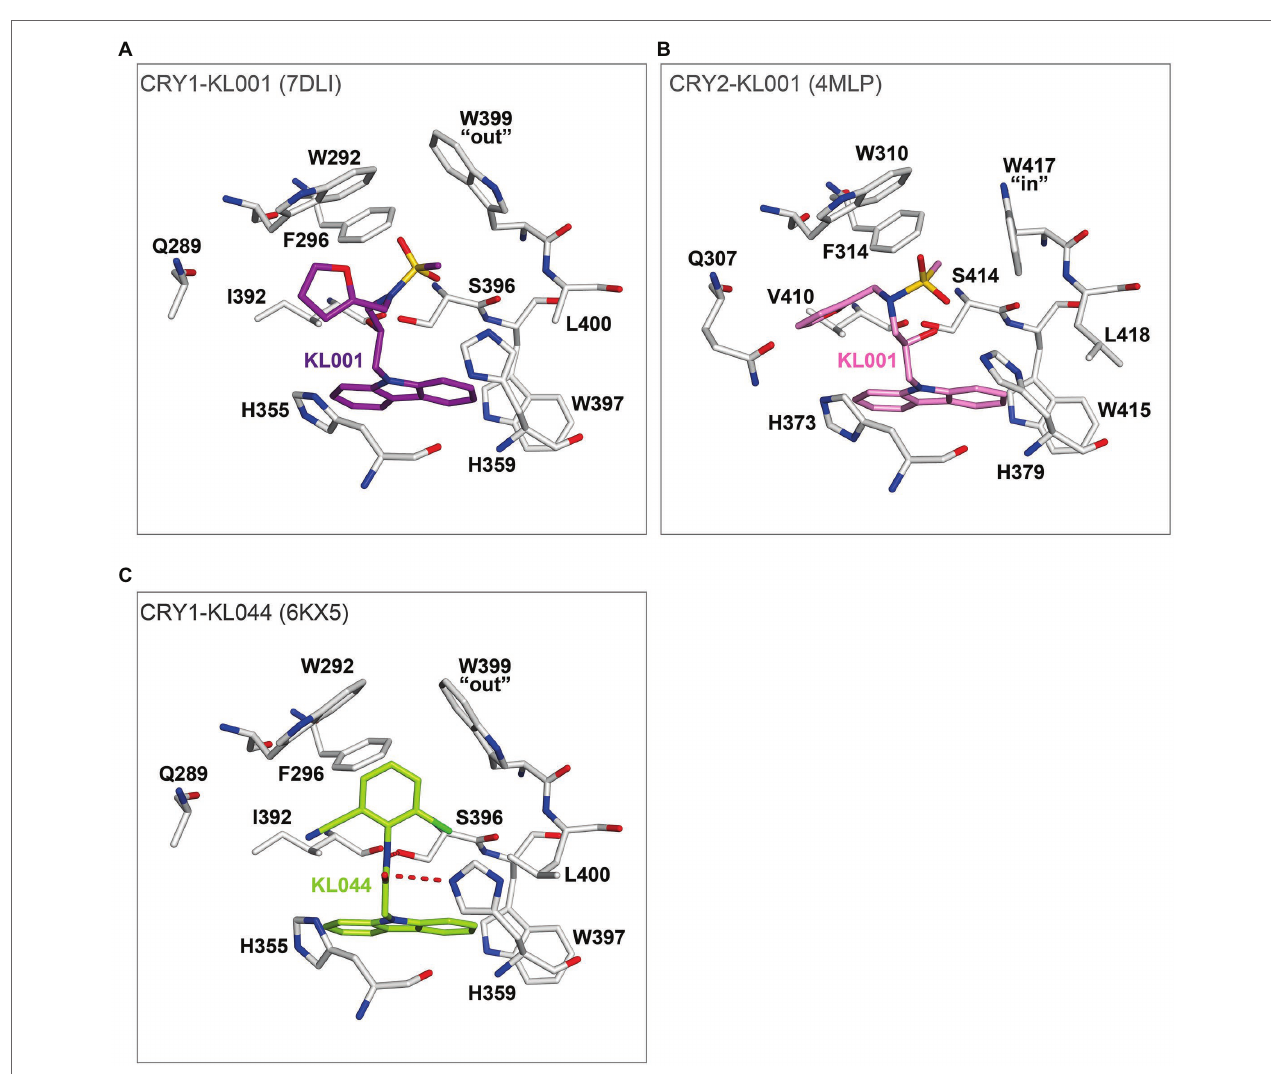
FIGURE 7 | The binding modes of isoform non-selective CRY compounds. (A) Crystal structure of CRY1-KL001 (7DLI). The carbazole and hydroxypropyl linker of KL001 (purple) stably interacted with hydrophobic region 2 and the affinity region of CRY1 (white), respectively. In contrast, the methanesulfonamide and furan groups have greater flexibility and located in hydrophobic region 1 with an intrinsic gatekeeper W399 “out” conformation. (B) Crystal structure of CRY2-KL001 (4MLP). KL001 (pink) can bind to intrinsic FAD pocket conformations, including gatekeeper W417 “in” of CRY2 (white). (C) The potent CRY activator KL044 formed stable hydrogen bonds with the FAD pocket. The amide linker in KL044 (lime green) formed a hydrogen bond with H359 in addition to a canonical hydrogen bond with S396. The chlorobenzonitrile group formed hydrophobic interactions with W292, F296, and W399, and a CH–Cl interaction with L400 in hydrophobic region 1. Furthermore, the intrinsic gatekeeper W399 “out” conformation could accommodate the chlorobenzonitrile. The carbazole interacted with multiple residues in hydrophobic region 2. Together, KL044 had an optimized binding